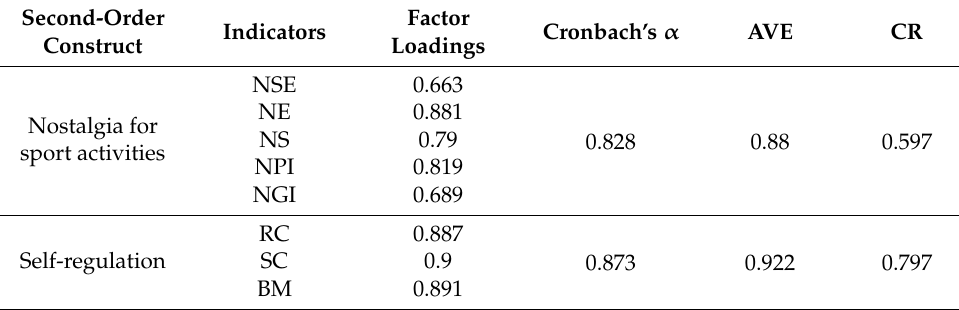
Table 2. Assessment of measurement model: higher-order